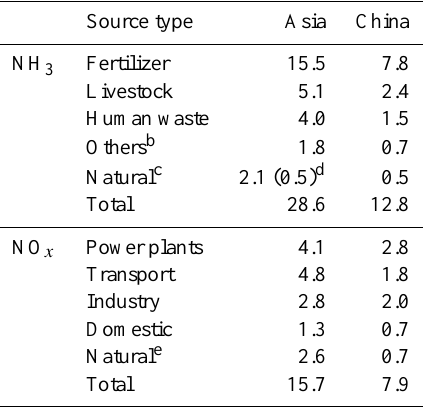
Table 2. Annual total NH 3 and NO x emissions over Asia and China a